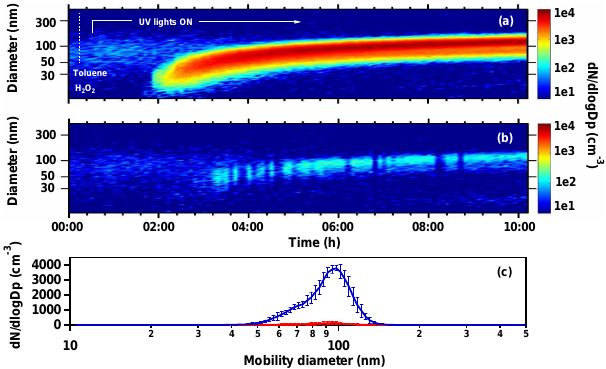
Figure 1. Time evolution of particle number size distribution dur- ing the dark ozonolysis of α -pinene, measured after (a) the bypass line at 25 ◦ C and (b) the TD set at 400 ◦ C. The color scale represents particle number concentration. (c) Average particle number size dis- tribution of α -pinene SOA (15 scans, 3min time span), for cham- ber measurements, at 25 ◦ C (blue), and loss-corrected TD measure- ments, at 400 ◦ C (red), for Exp. 1 (see Table 1 for details). Vertical lines correspond to confidence intervals.